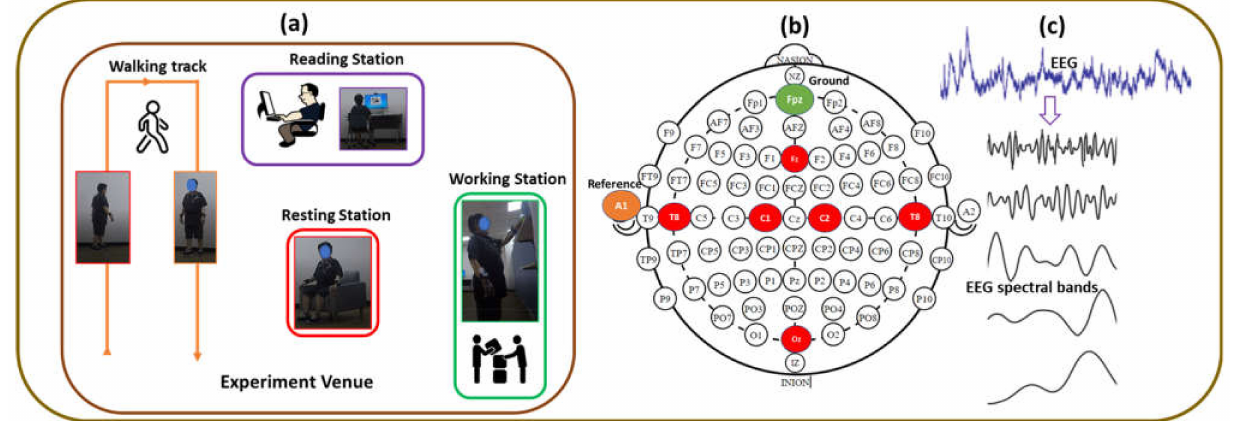
Figure 2. EEG Signal Processing and electrode positions and layout. ( a ) Experimental scenario, ( b ) six-channel EEG, reference and ground electrodes position based on Standard 10–20 EEG system, ( c ) EEG Signal